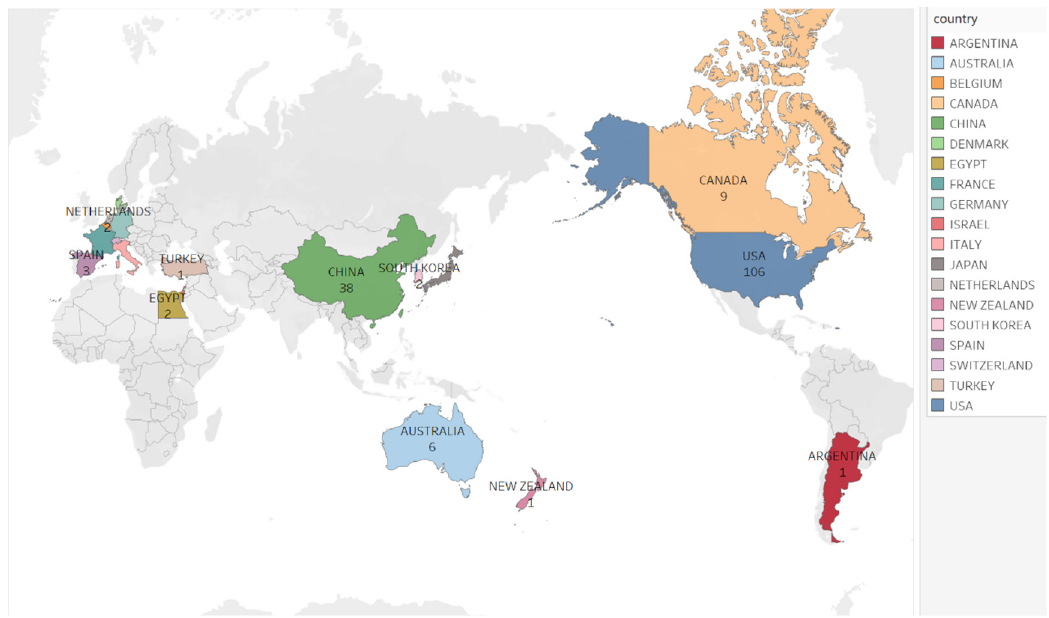
Figure 3. Total number of publications in the top 20 countries. USA 106, China 38, Germany